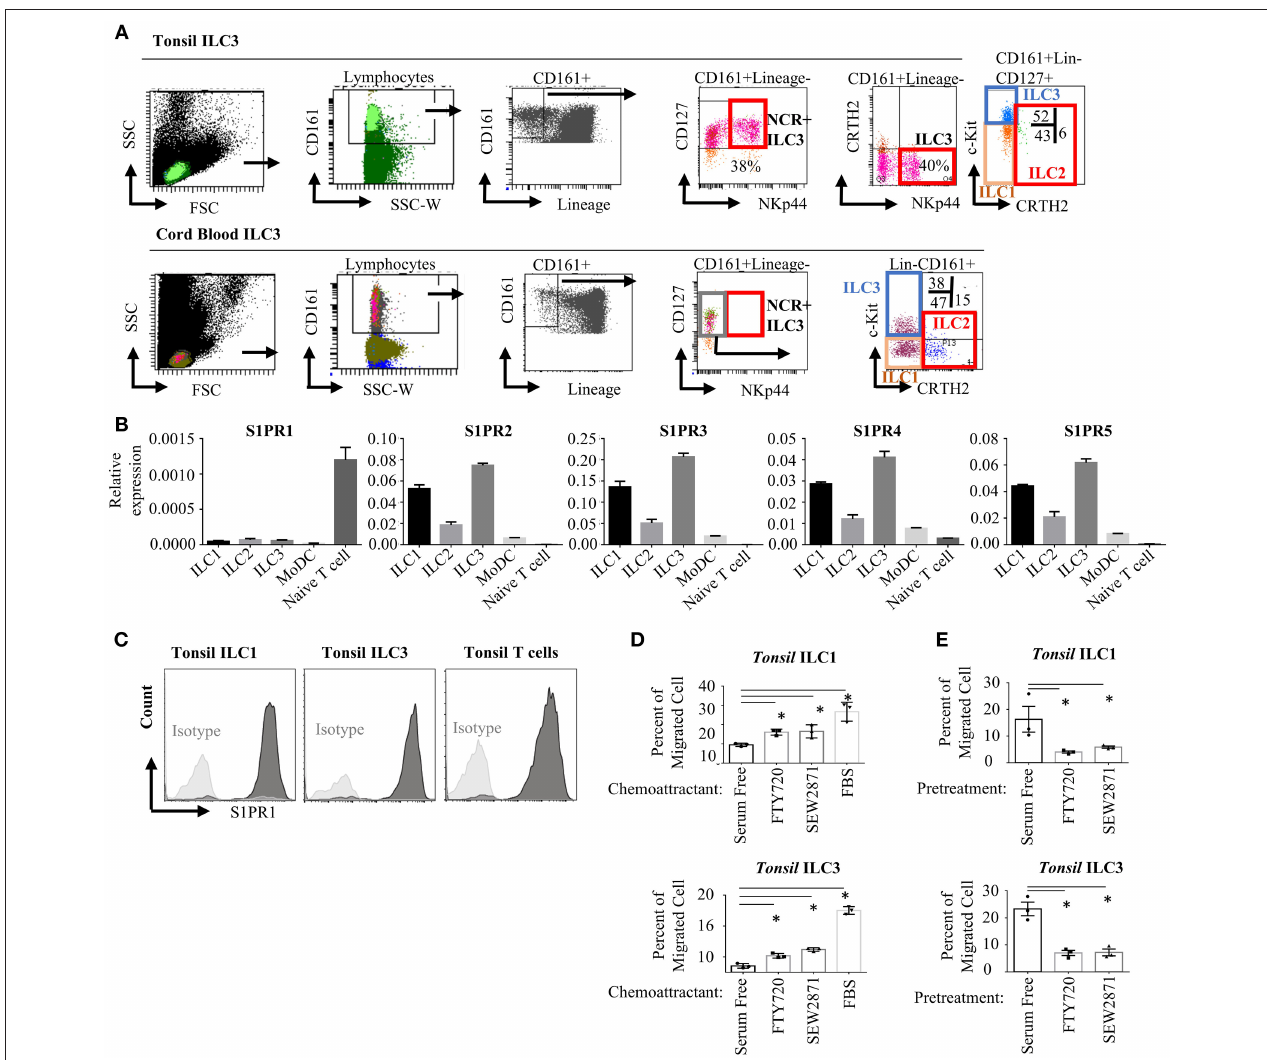
FIGURE 1 | Human ILC subsets express S1P receptors and migrate toward S1P analogs in vitro . (A) Gating strategy for human ILC subset isolation from tonsil and cord blood. (B) Sorted ILC subsets were used to determine relative gene expression of S1P receptors (S1PR1, S1PR2, S1PR3, S1PR4, S1PR5) via real time qPCR. (C) Human tonsil ILC1 and ILC3 were stained for S1PR1 to determine protein expression, a representative histogram flow plot with isotype control. (D) Migration of ILC1 and ILC3 cultured in serum free media toward FTY720 and SEW2871 gradient. Percentage of cells migrating into lower chamber of a trans-well plate quantified. (E) Migration of ILC1 and ILC3 pretreated with serum free media, FTY720 or SEW2871 for 2h toward FTY720. Percentage of cells migrating was charted. * p < 0.05. Experiments in (B–E) were performed three separate